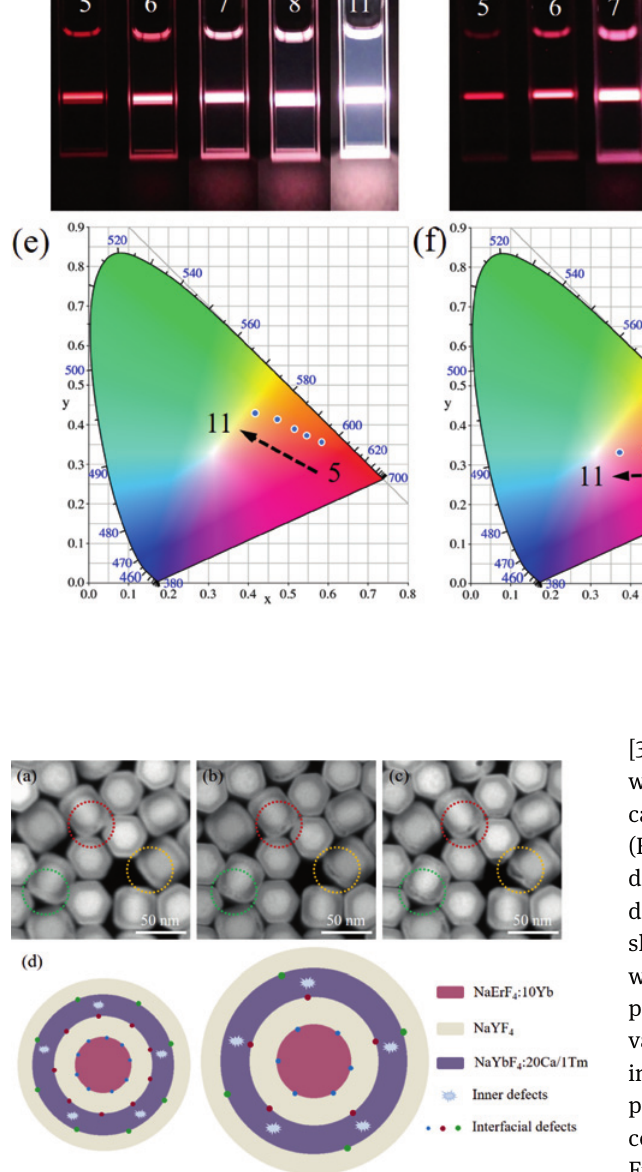
Figure 4: HAADF-STEM images of the core/dual-shell NCs under different e-beam irradiation time: 2 s (a), 10 s (b) and 20 s (c). (d) Schematic illustration of the inner/interfacial defects variations in the core/triple-shell NCs with different